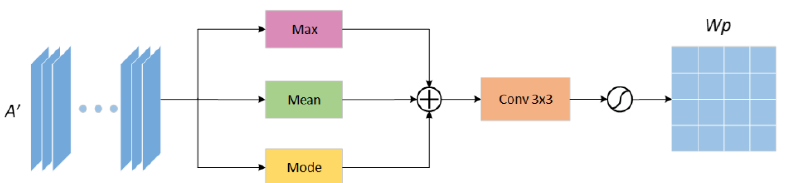
Figure 4. The architecture of the channel attention mechanism (CAM) module.